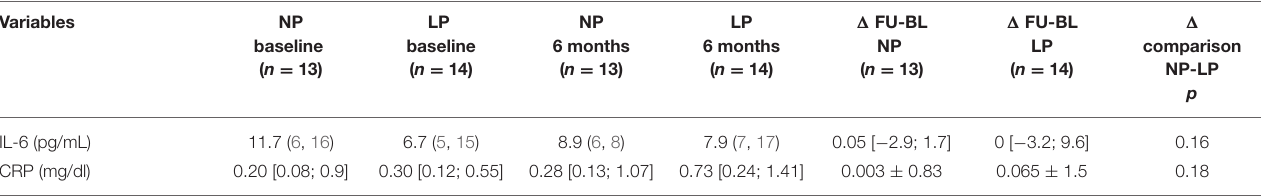
TABLE 6 | Assessment of inflammatory status.